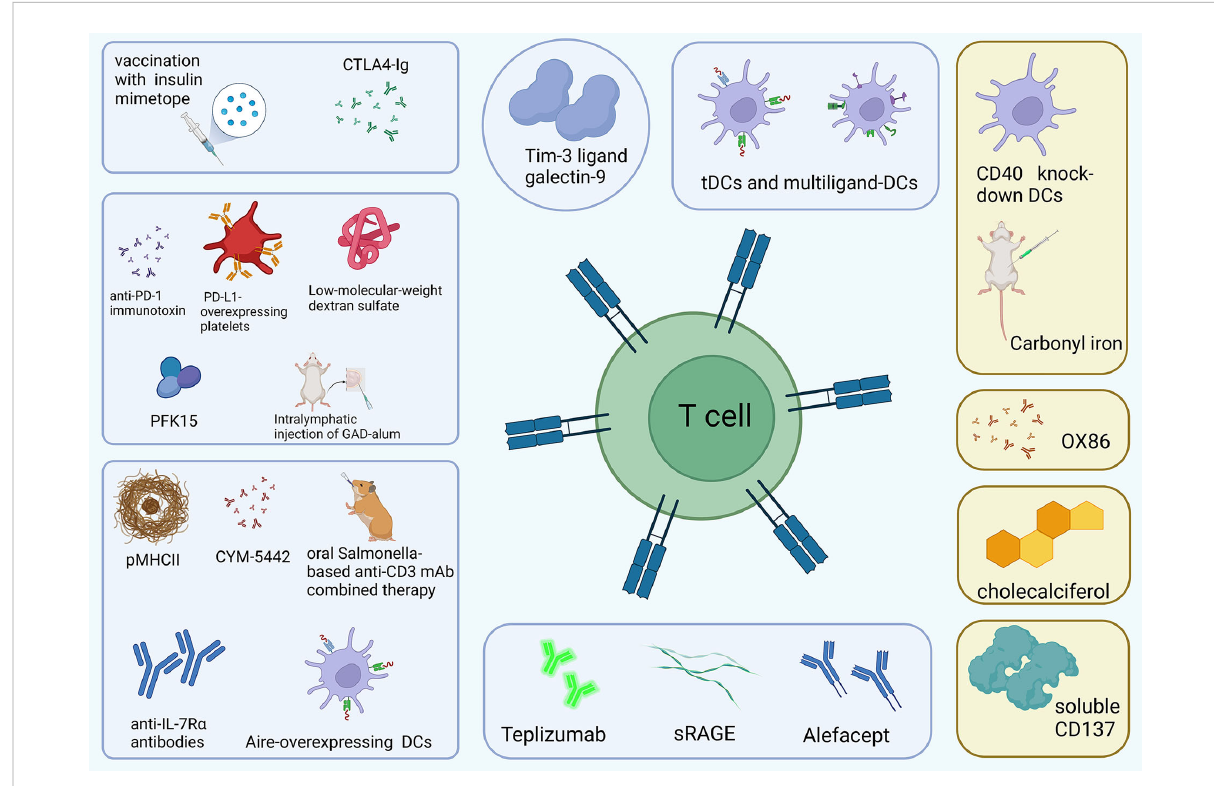
FIGURE 3 The treatment measures for T1D via regulating T cells. The blue rectangles represent co-inhibitory molecules while the yellow rectangles represent co-stimulatory molecules (created with